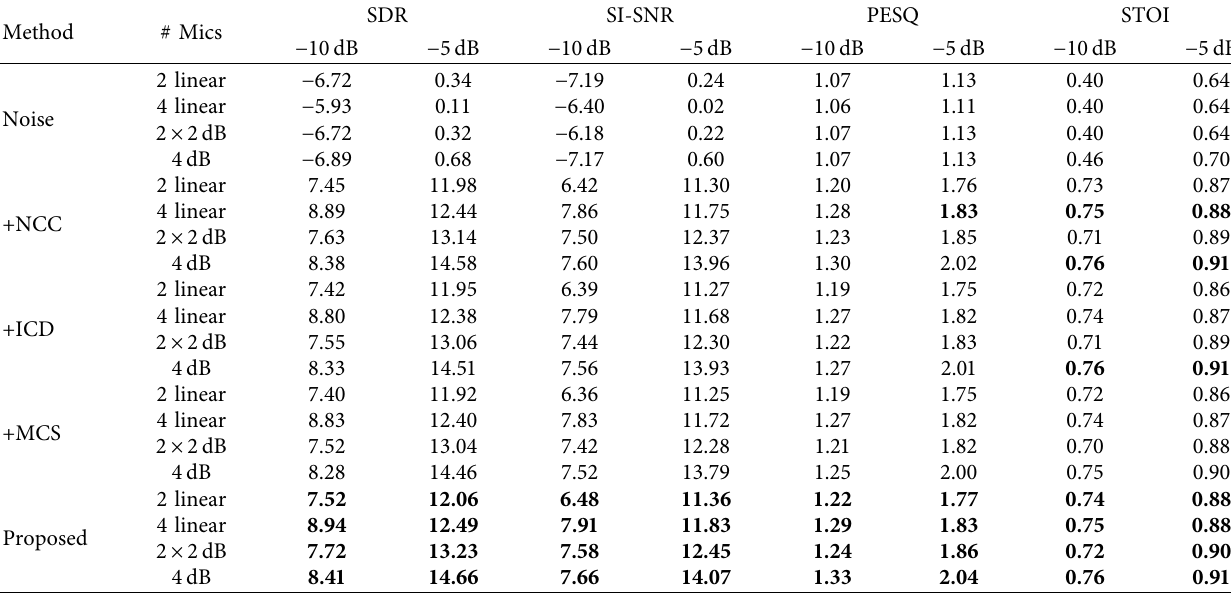
Table 1: Evaluation results of our proposed model compared with other methods on the same dataset. Four metrics and two SNRs are considered.